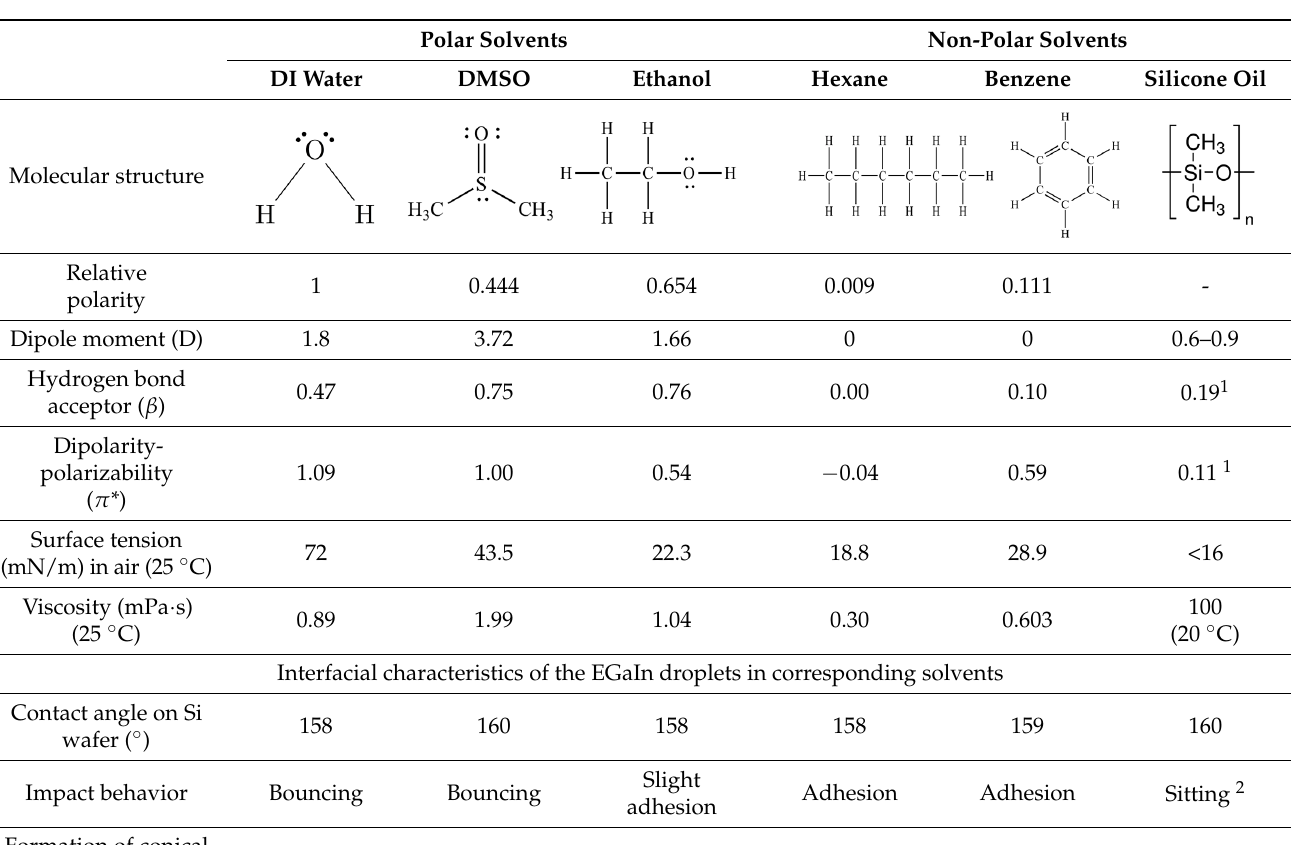
Table 1. Molecular structures and physical properties of solvents used and interfacial characteristics of EGaIn in the corresponding solvents.